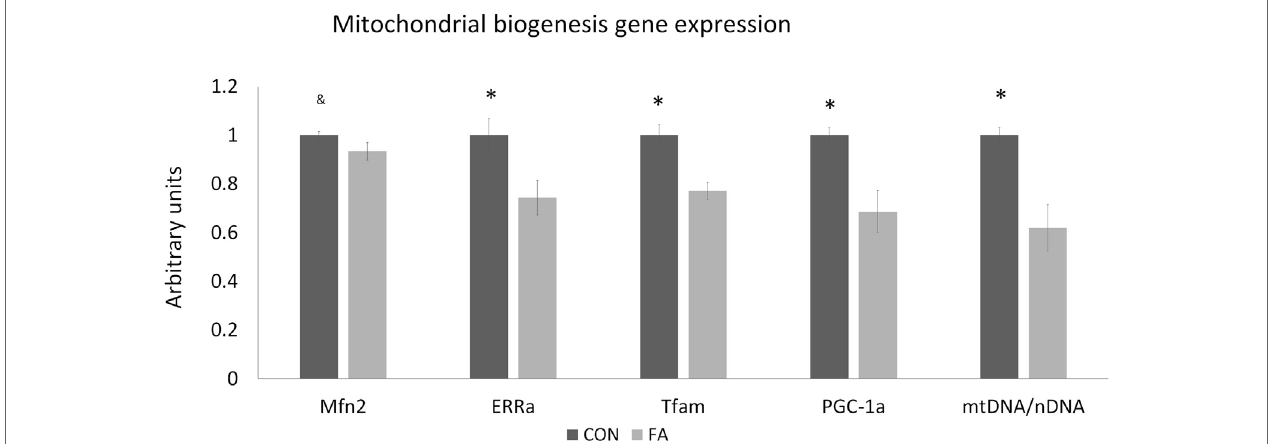
FigUre 4 | The relative gene expression related to mitochondrial biogenesis and function of C2C12 cells in control (CON) and EPA/DHA (FA) medium. Data show the change of their mRNA expression in FA group compared with CON group. The relative expressions were calculated in arbitrary units. * P < 0.05 and & P < 0.1; n =